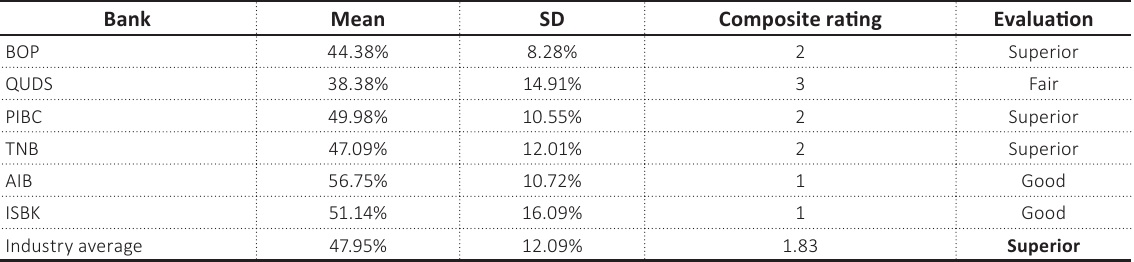
Table 9. Average liquid assets (2007–2017)